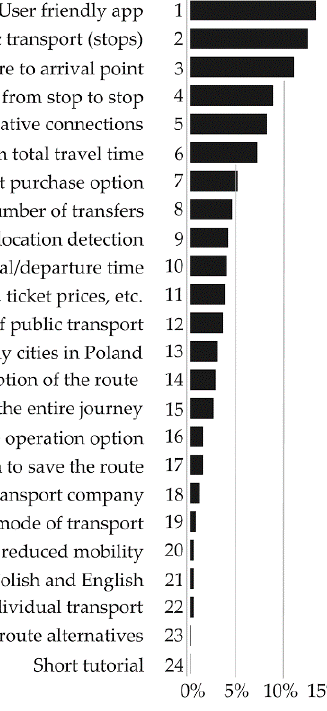
Figure 12. List of application elements that the respondents considered important.